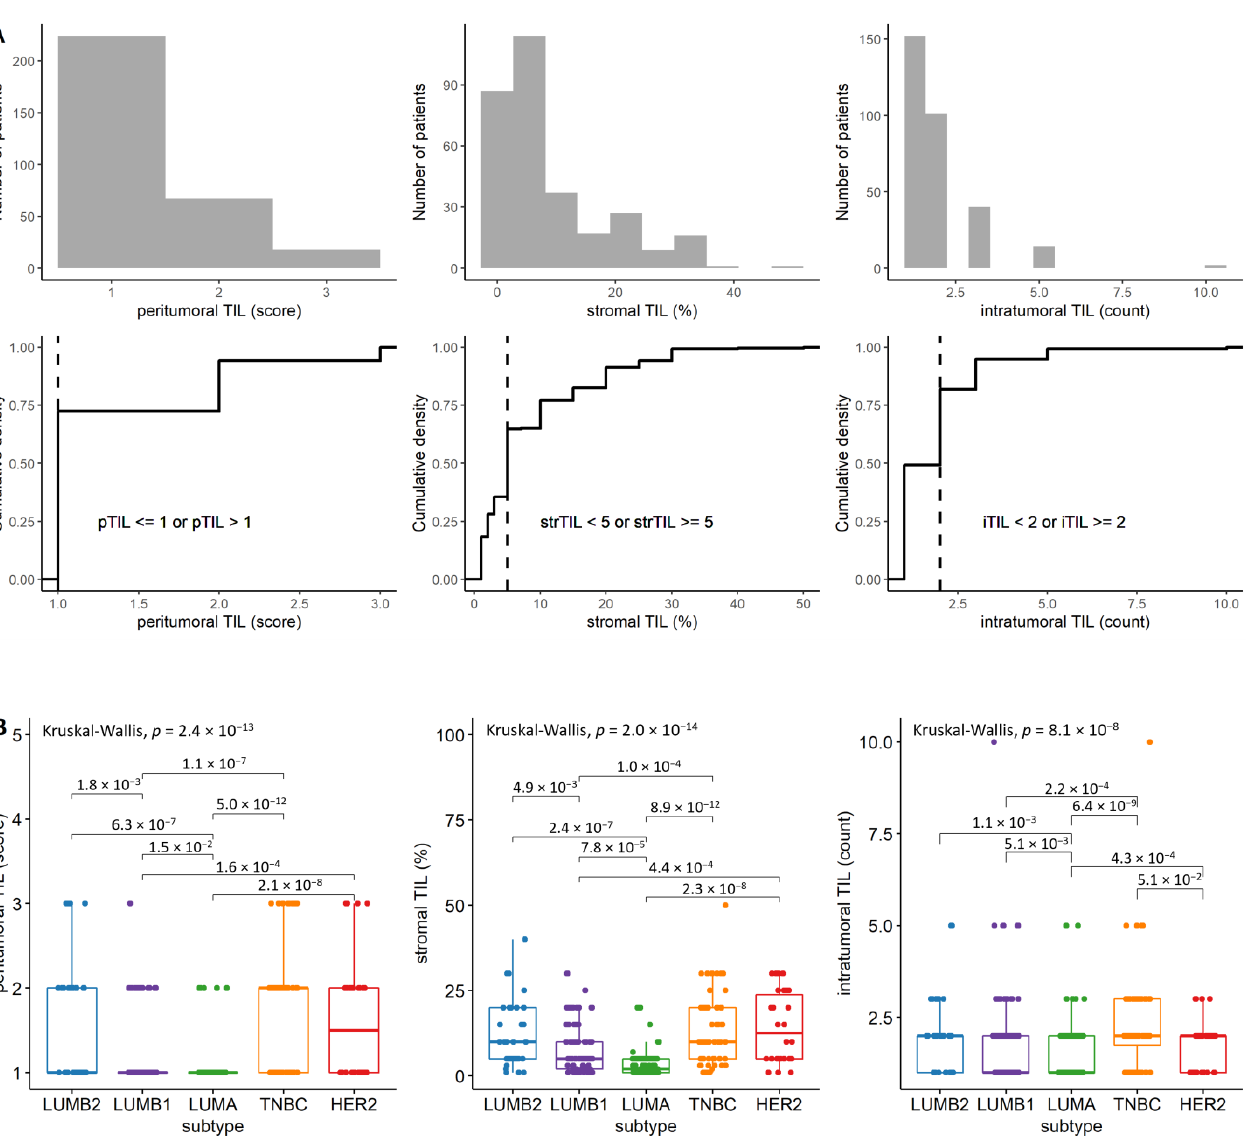
Figure 1. The distribution of TIL categories across the analyzed cases: A, The distribution of patients (n = 309) in the different TIL localization categories. Patients were stratified based on the thresholds indicated with vertical lines for subsequent analyses. B, The distribution of peritumoral, stromal and intratumoral TILs in different breast carcinoma subtypes ( n = 305). Only pairwise comparisons with Wilcoxon-test p -values less than 0.100 are shown.